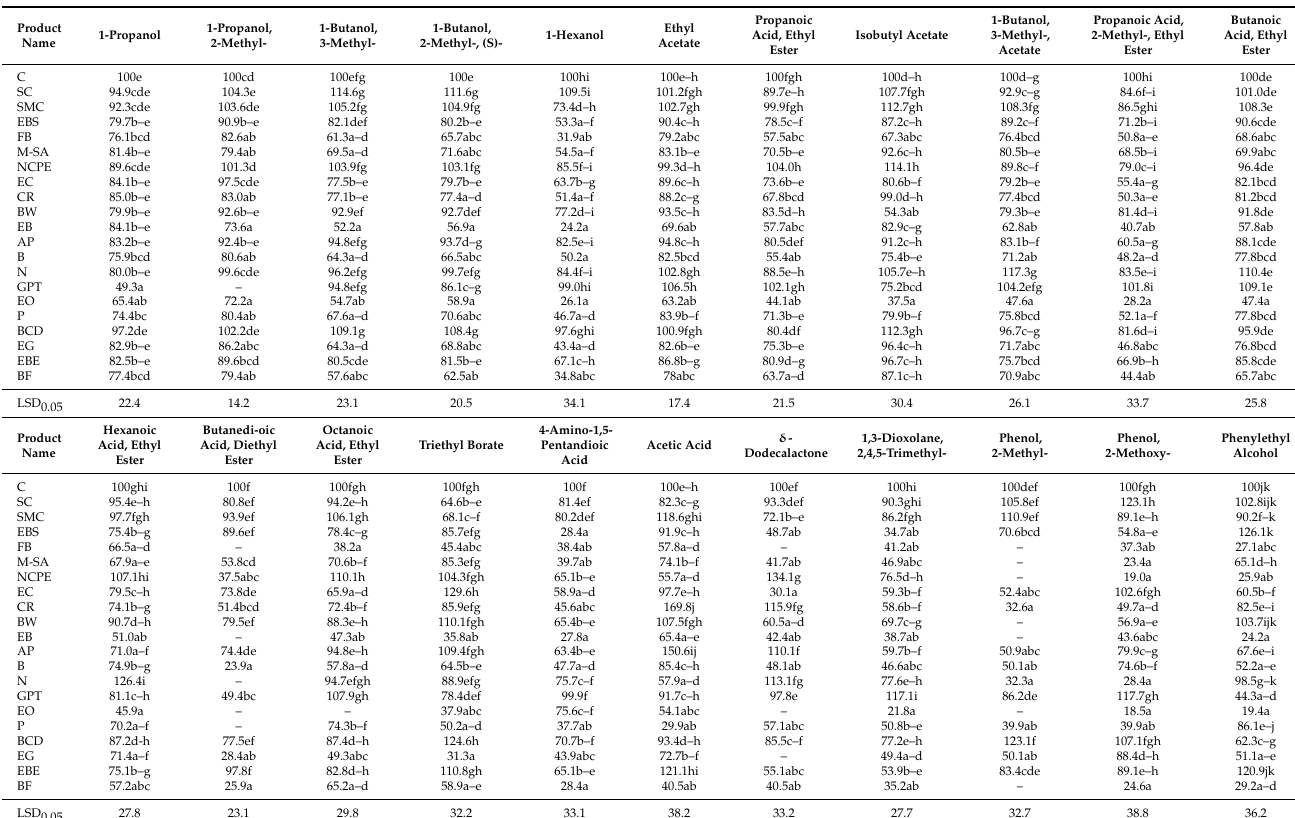
Table 6. Percentage contribution of twenty-two volatile organic compounds (VOCs) to control (C) treatment in white wine samples treated with twenty-one bentonite products including control treatments (Debrecen-Pallag, Hungary). The order of VOCs follows the increasing retention time (see Table 2), which corresponds to the elongation of the carbonic chain. The relative presence of VOCs is expressed in the percentage of control (C) treatment. Different letters within each column are significantly different among the bentonite product treatments at p = 0.05 according to LSD t-tests (LSD 0.05 ). Order of used letter for significance differences: a, b, c, d, e, f, g, h, i, j, k, l, m. ‘-‘: the VOCs is not detected in the treatment. Explanations for bentonite product name abbreviations are given in Table